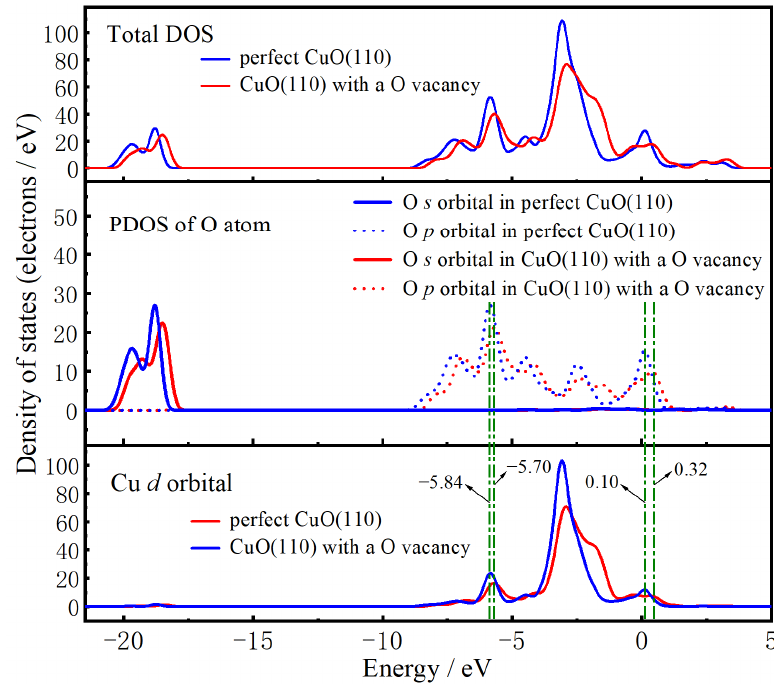
Figure 11. The TDOS of Cu(110) slab and the PDOS of the O atoms.